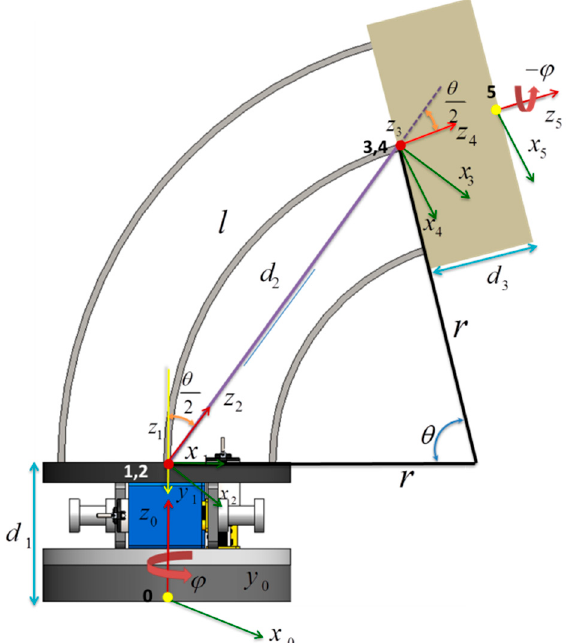
Figure 4. Denavit–Hartenberg parameter representation for kinematic modeling. l = length of the flat springs; ϕ = rotation of the module about the z -axis; θ = bending angle of the module; r = radius of the arc; d 1 = height of the actuator module; d 2 = translational length of the prismatic joint; d 3 = thickness of the upper plate of the bending module.